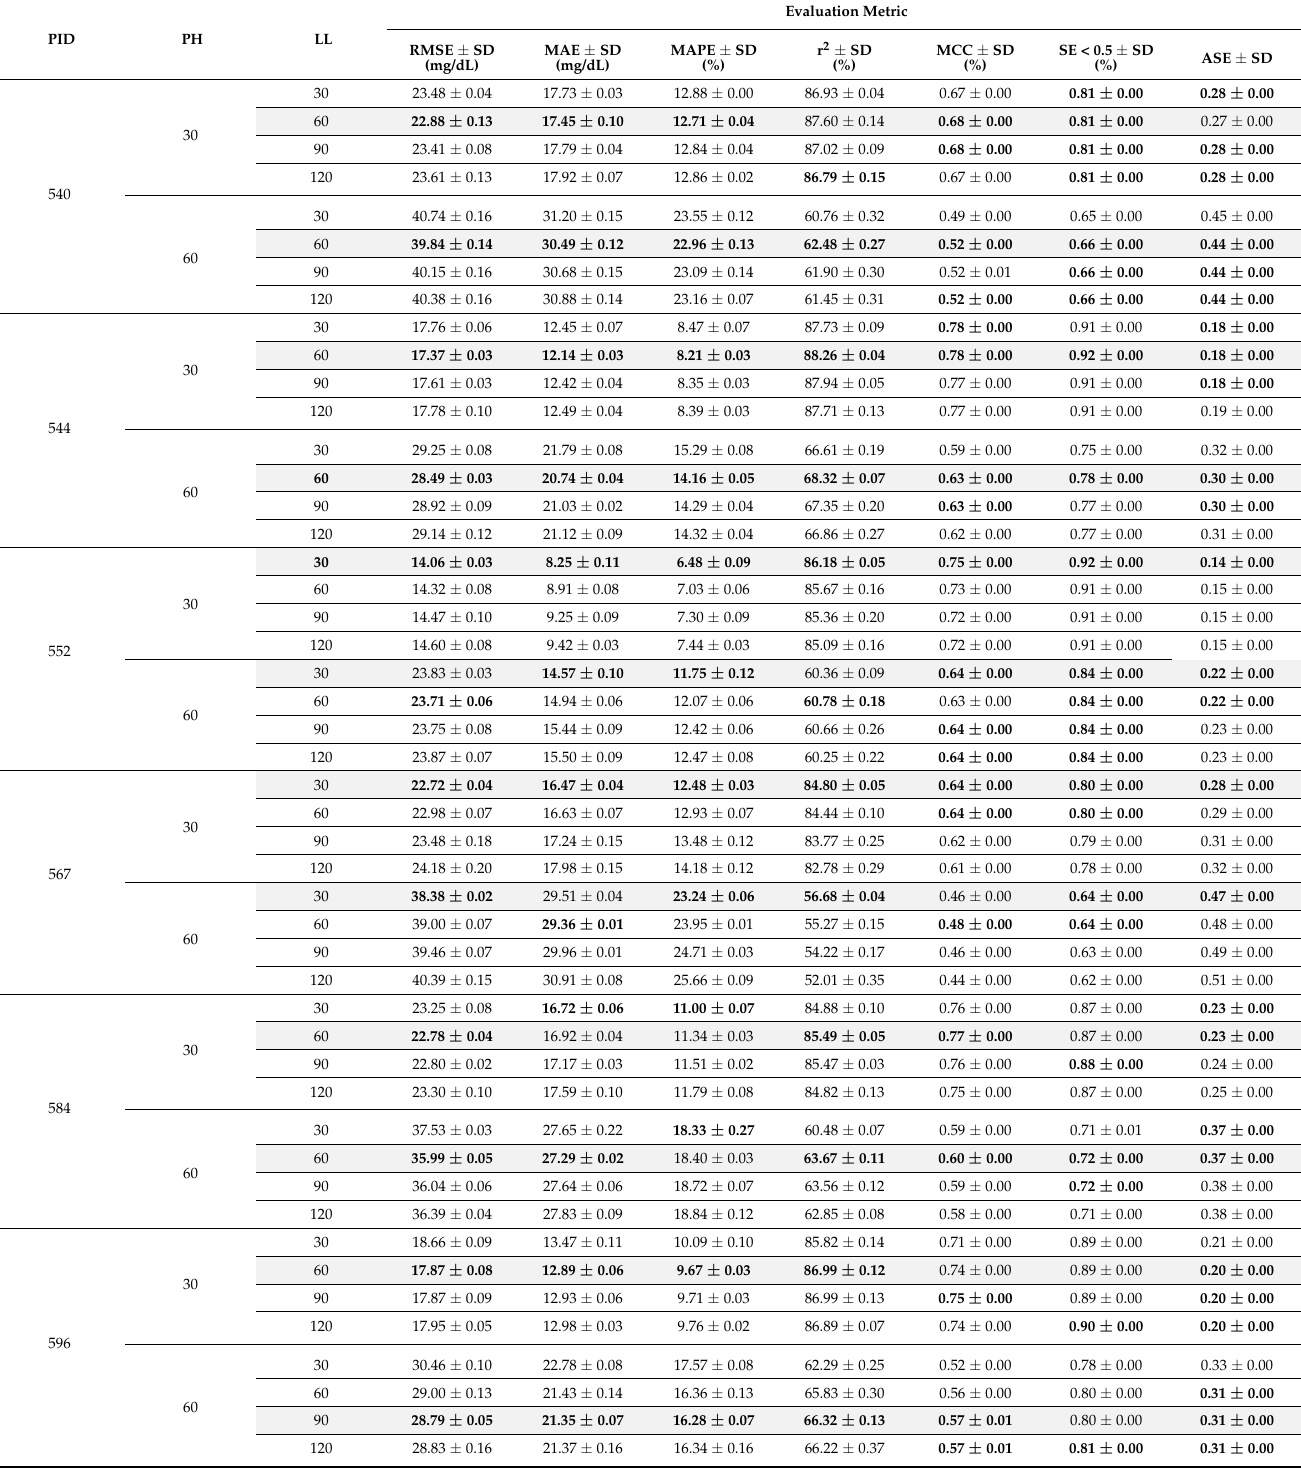
Note. Values in bold indicate the best evaluation outcome for each metric in each learning scenario, and grey highlights denote the best model in each scenario based on the best-achieved evaluation metrics. Note. PID: patient identification; PH: prediction horizon; LL: lag length; RMSE: root mean square error; SD: standard deviation; MAE: mean absolute error; MAPE: mean absolute percentage error; r 2 : coefficient of determination; MCC: Matthew’s correlation coefficient; SE: surveillance error; ASE: average surveillance